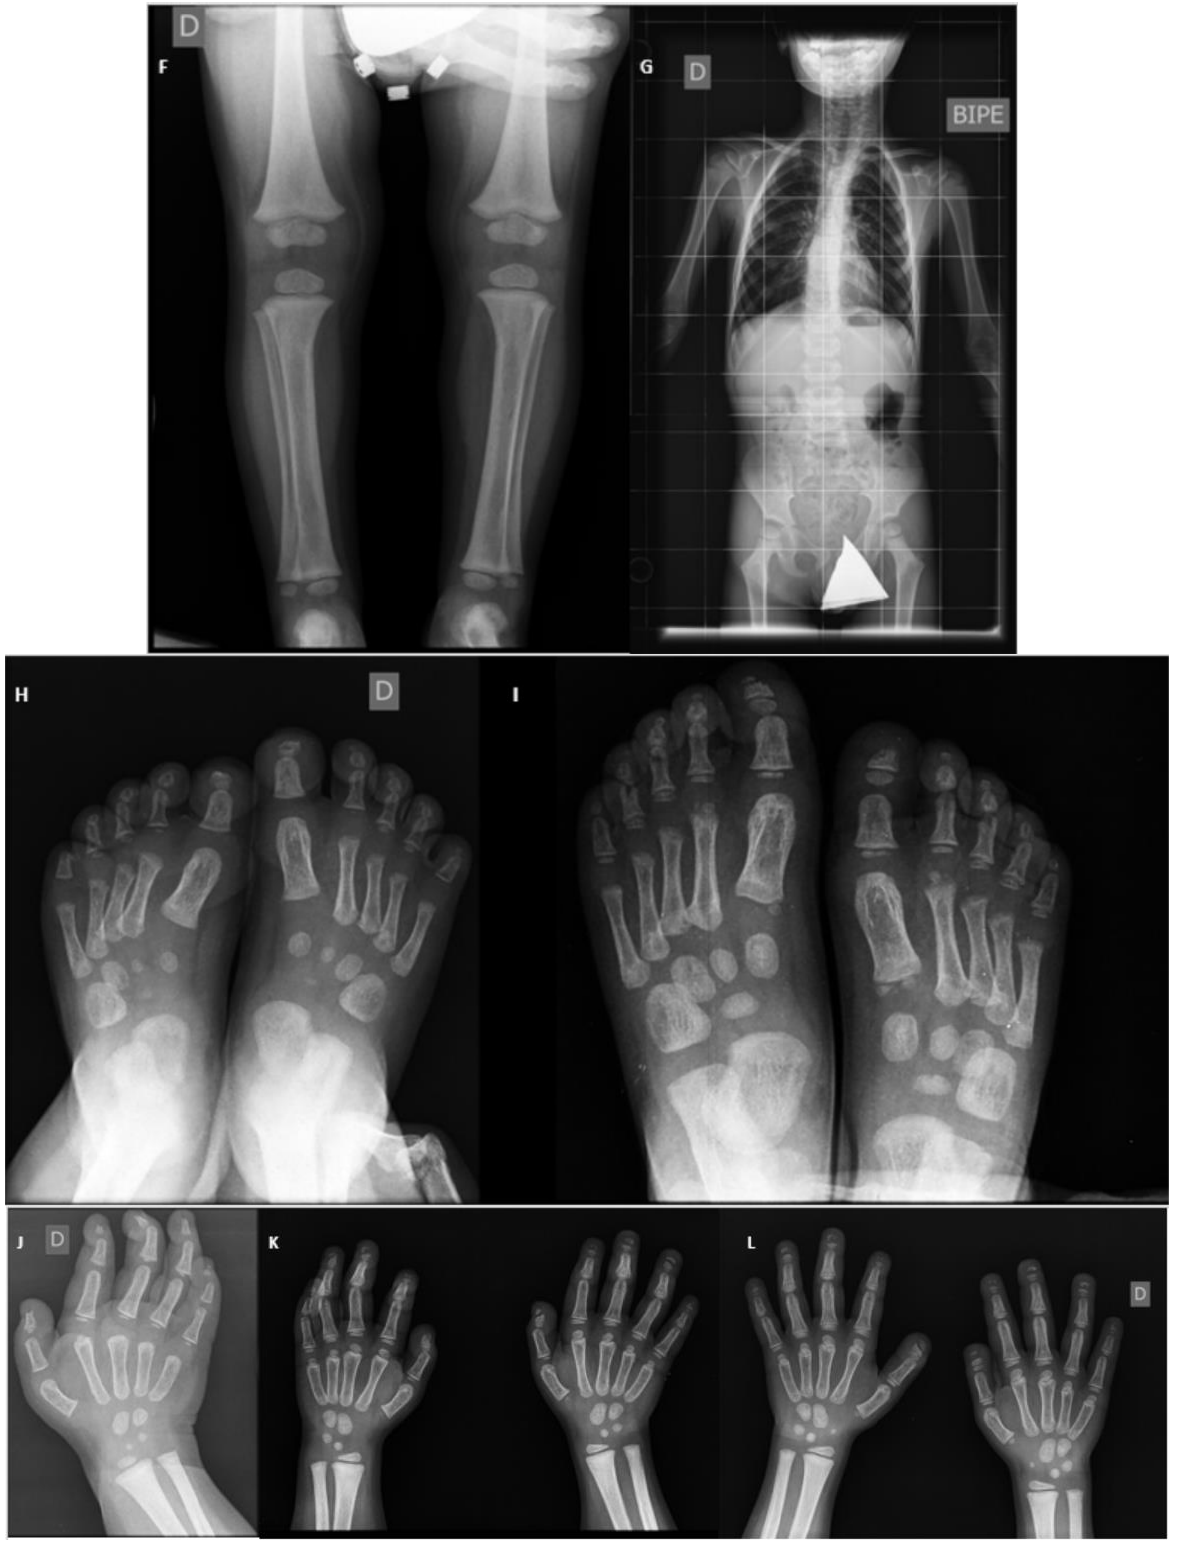
Figure 3. Radiological controls. ( A ) Skull, year 2012. ( B ) Lateral skull, year 2012. ( C ) Spinal column, year 2012. ( D ) Left arm, year 2013. ( E ) Pelvis, year 2013. ( F ) Legs, year 2014. ( G ) Standing position, year 2015. ( H ) Feet, year 2012. ( I ) Feet, year 2016. ( J ) Hands, year 2012. ( K ) Hands, year 2014. ( L ) Hands, year